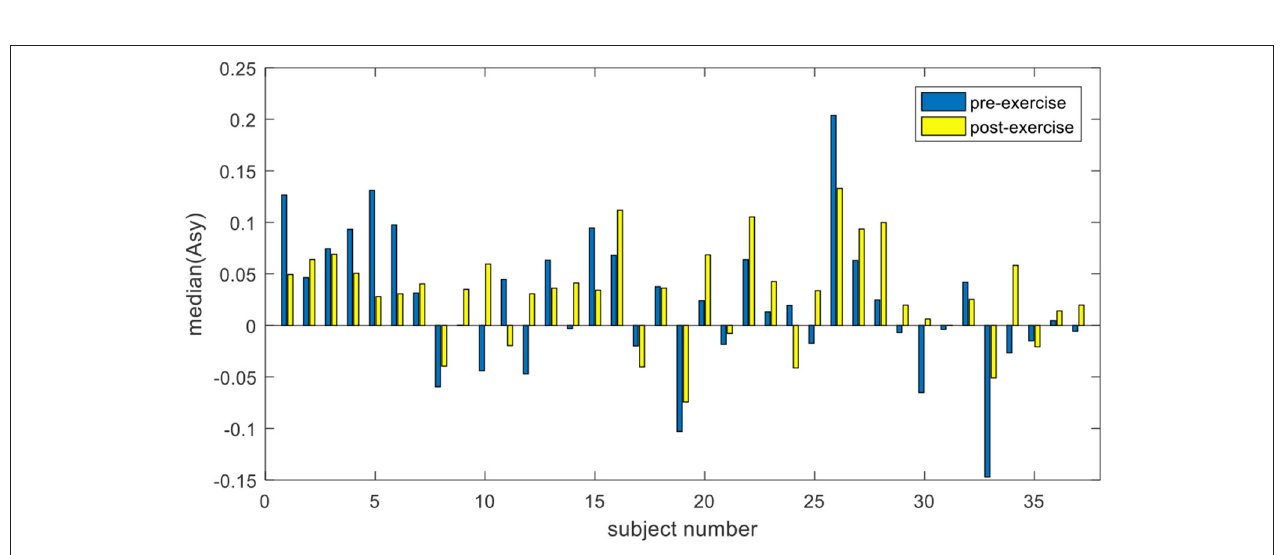
FIGURE 7 | Comparison of Asy. median in the exercise